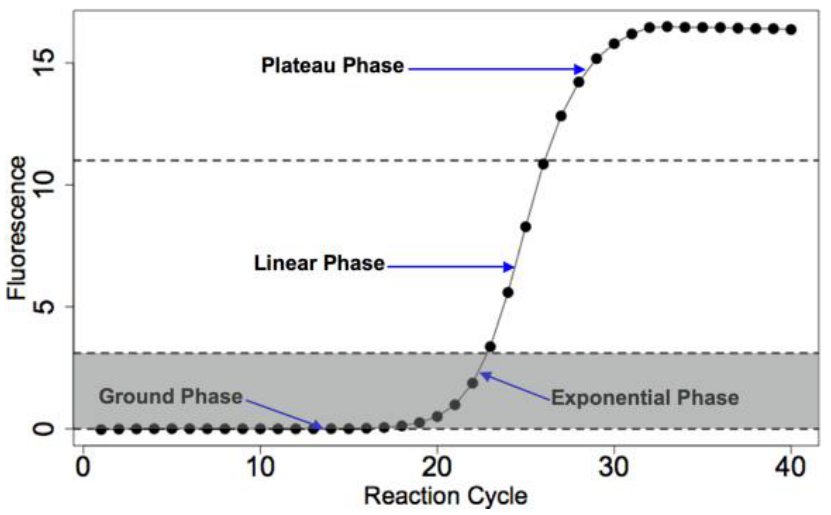
FIGURE 1. An example of a RT-qPCR amplification plot showing the four phases of a PCR. Dashed lines denote the approximate boundaries of each phase. The exponential phase is highlighted in gray. Note that the bottom dashed horizontal line corresponds to the ground